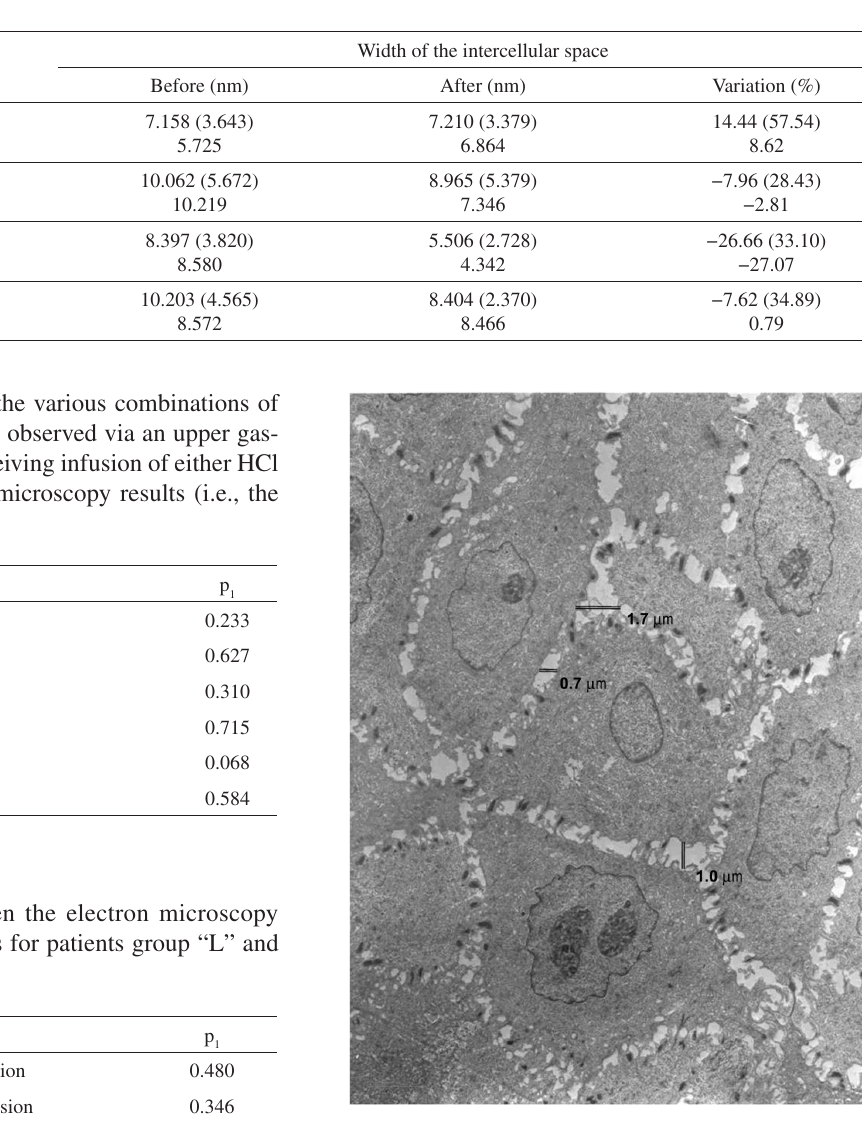
Figure 1 - Electron micrograph of the prickle cell layer of the esophageal epithelium from a patient with a normal esophagus prior to HCl infusion (magnification,